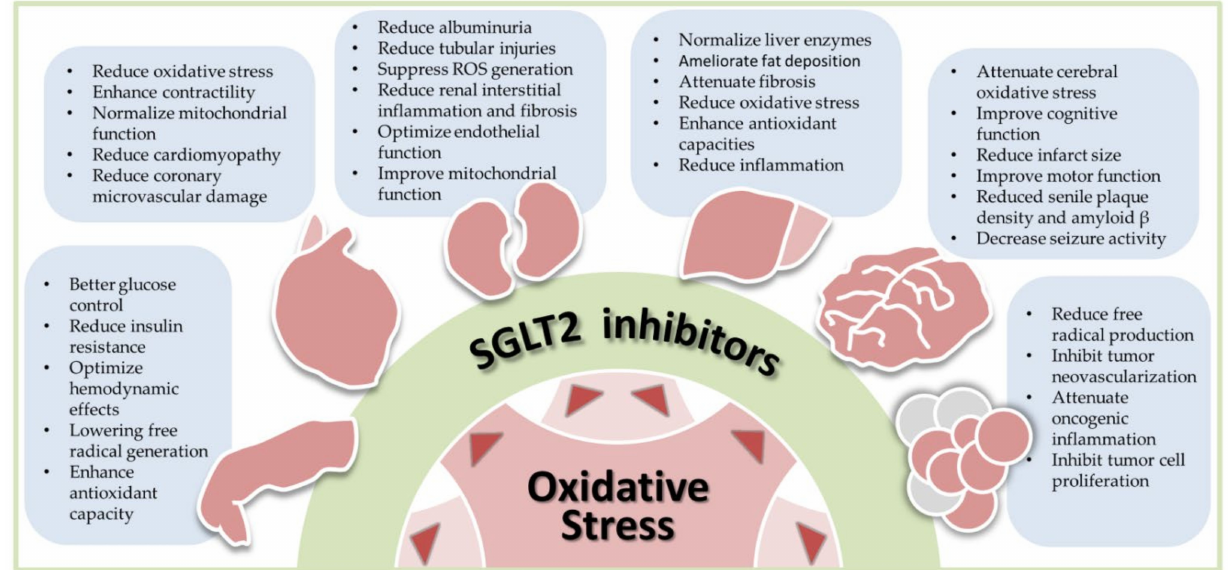
Figure 1. Antioxidant effects of sodium-glucose cotransporter 2 (SGLT2) inhibitors in human diseases, including diabetes, cardiovascular diseases, nephropathy, liver diseases, neural disorders, and cancers. Oxidative stress is commonly seen in human diseases. By reducing oxidative stress, SGLT2 inhibitors exhibit the therapeutic potential in these diseases. The bullet points listed in each blue box summarize results of preclinical and clinical studies in each specific disease. ROS, reactive oxygen